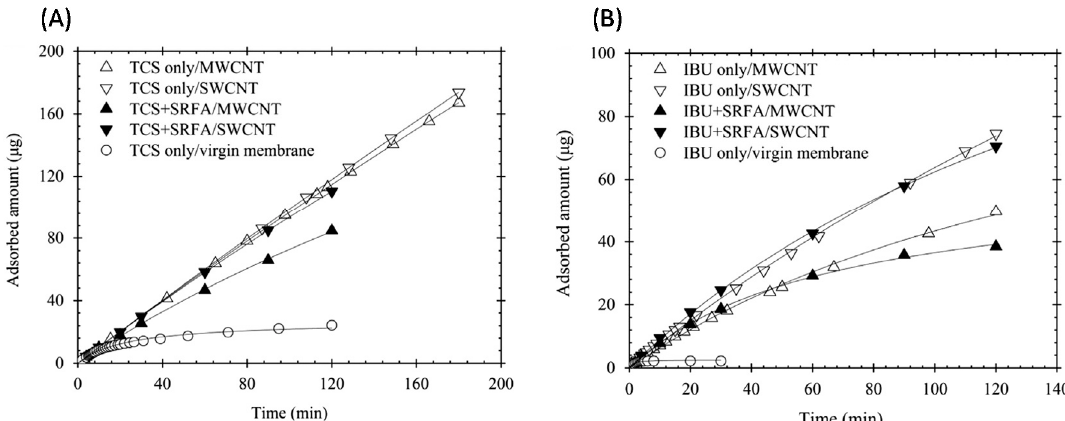
Figure 13. Effect of time on the adsorption of: ( A ) triclosan; and ( B ) ibuprofen by SWNT/PVDF and MWNT/PVDF composite membranes, both in the absence and presence of Suwannee River fulvic acid (SRFA). Reprinted with permission from Reference [100]. Copyright Elsevier, 2015.